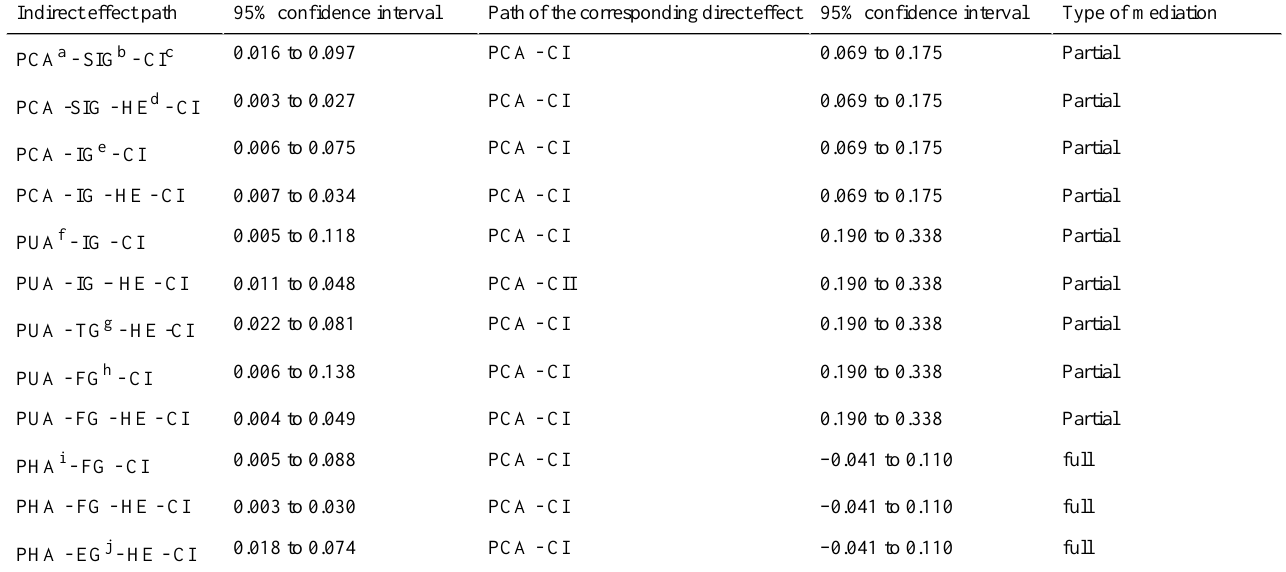
Table 3. Bootstrapping